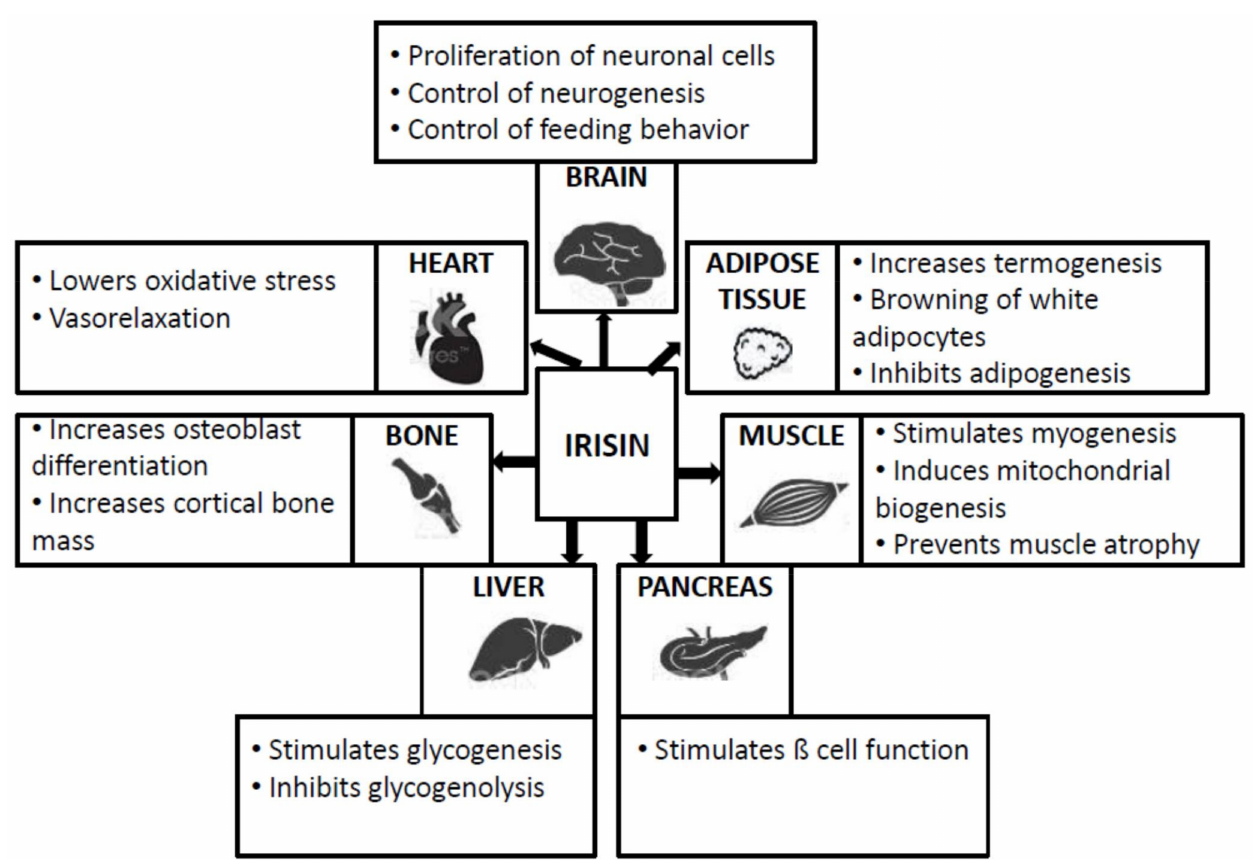
Figure 1. Existing data about the actions of